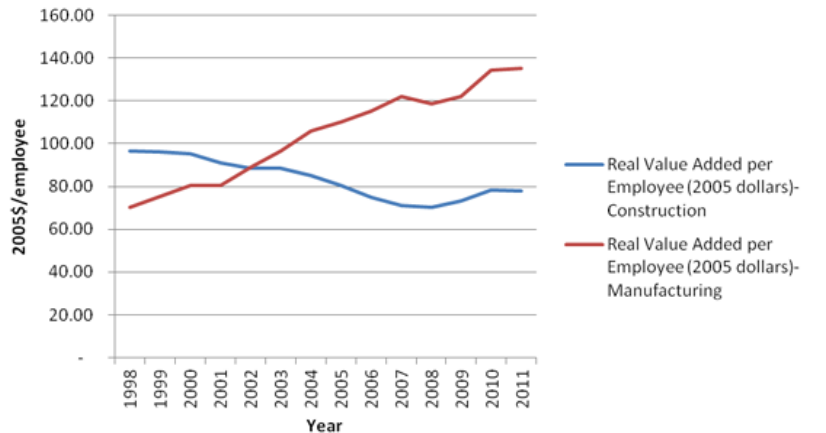
Figure 1 Value Added per US Employee in 2005 dollars Source: Teicholz